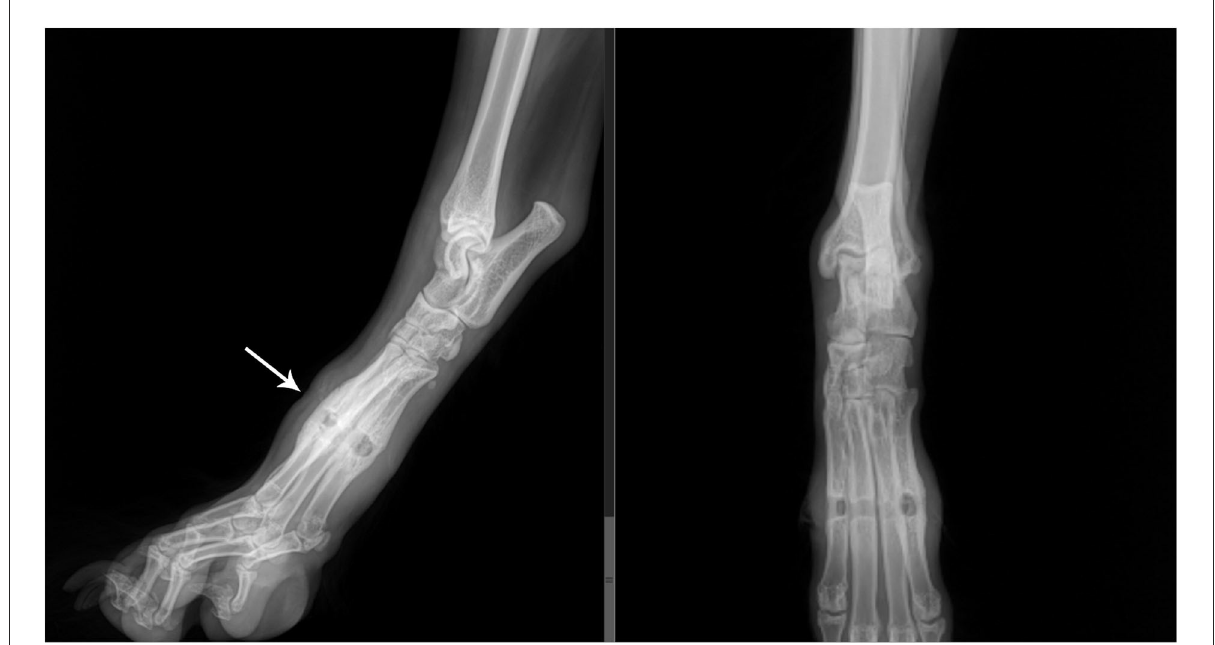
FIGURE1 Lateral and dorsoplantar view of the right metatarsus showed mid-diaphyseal, well delineated, horizontal lysis of metatarsals 2–5, with ovoid, discrete geographic lysis of metatarsals 2 and 5. Smoothly marginated new bone is seen on the lateral aspect of metatarsal 5 and the plantar aspect of the metatarsals on the lateral view. Moderate soft tissue swelling was noted surrounding the lucencies with a subtle dorsal indentation of the soft tissues (arrow) at the level of the boney lysis best seen on the lateral view.